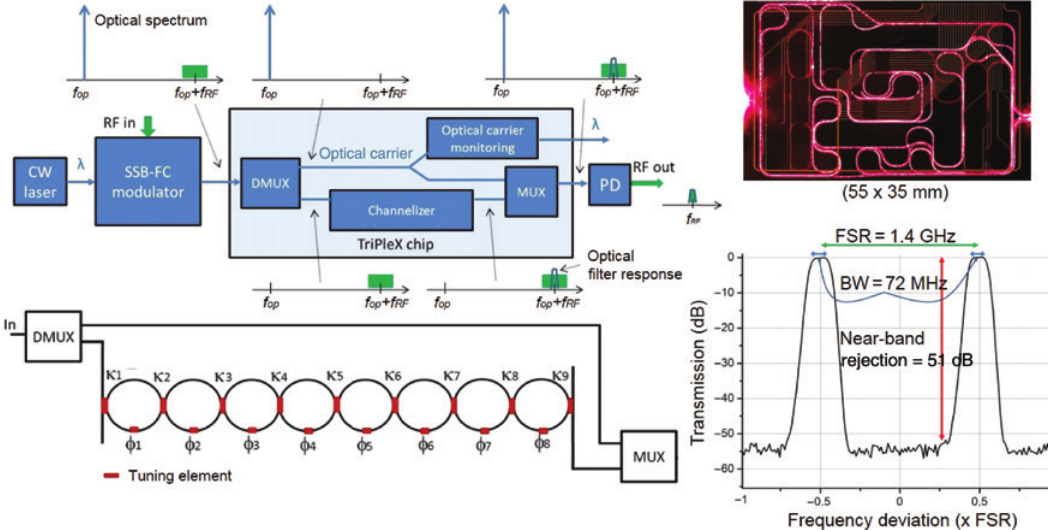
Figure 10: Design and realization of an on-chip optical filter for microwave photonic implementation of an RF bandpass filter with a band- width of 72 MHz [74] (Copyright in 2014,